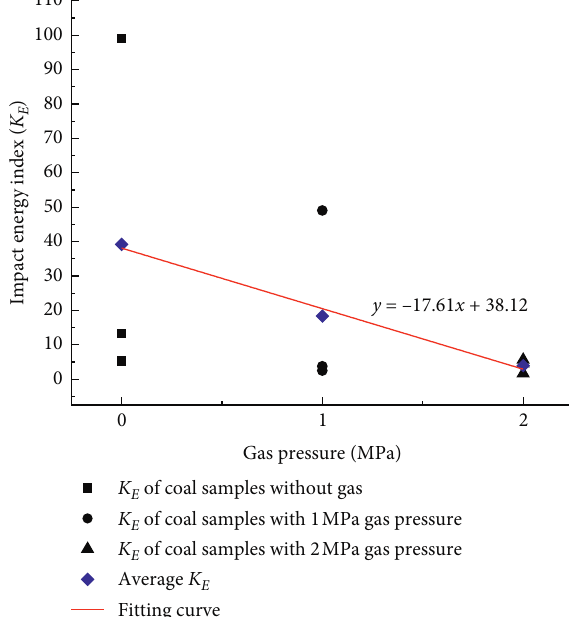
Figure 14: Relation curve between K